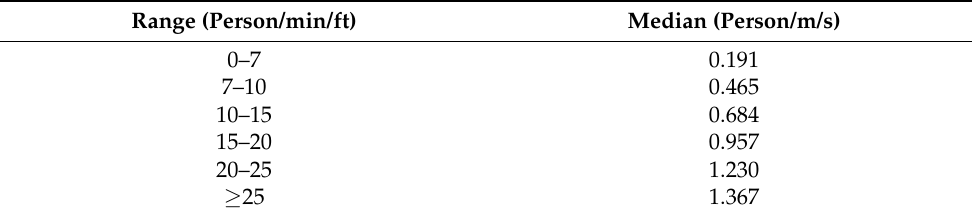
Table 2. Average Flow